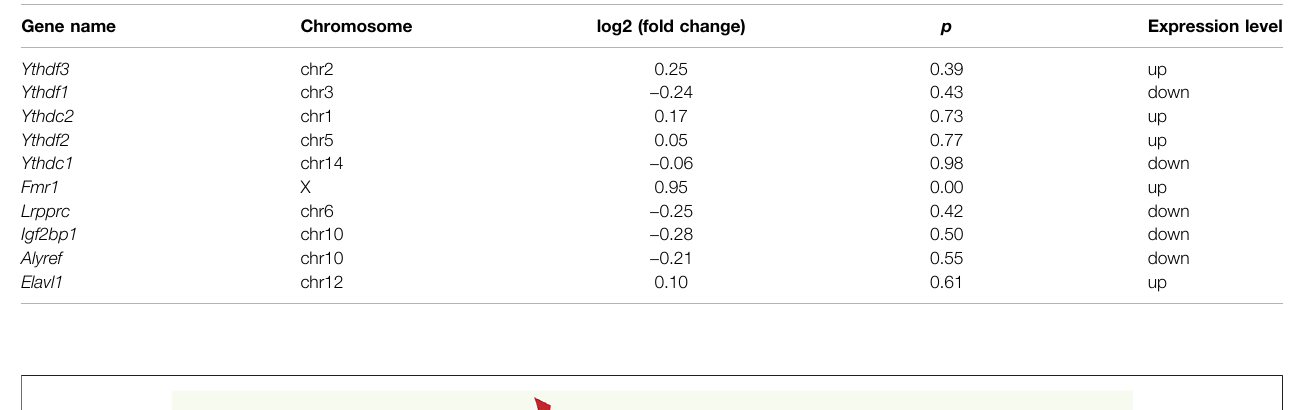
TABLE 5 | Expression of m6A methylation regulator.